Question: Give a one-sentence summary of this figure.
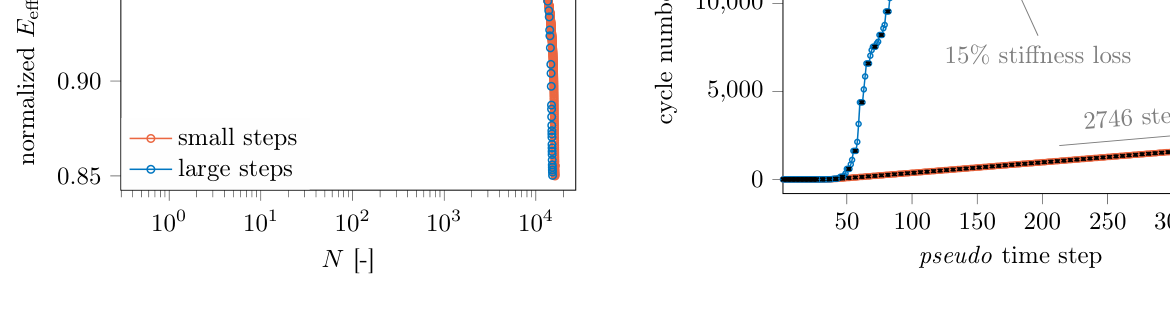
Answer: Stiffness reduction with number of cycles